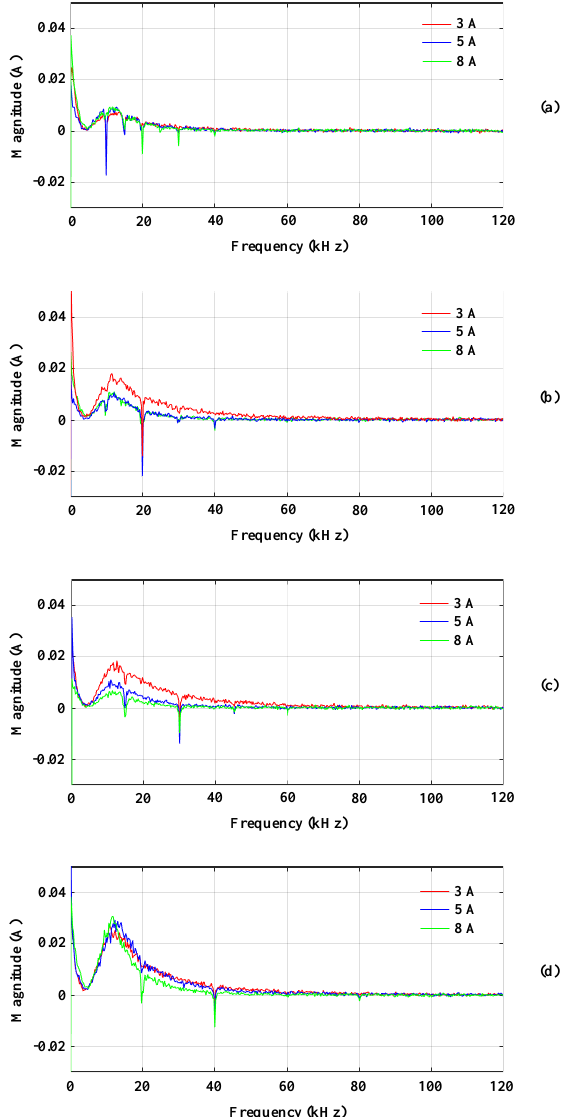
Figure 4. FFT di ff erences after and before arc generation based on the current magnitude and switching Figure 4. FFT differences after and before arc generation based on the current magnitude and frequency in I arc 1 : ( a ) 5 kHz, ( b ) 10 kHz, ( c ) 15 kHz, and ( d ) 20 switching frequency in 𝐼 𝑎𝑟𝑐1 : ( a ) 5 kHz, ( b ) 10 kHz, ( c ) 15 kHz, and ( d ) 20 kHz.